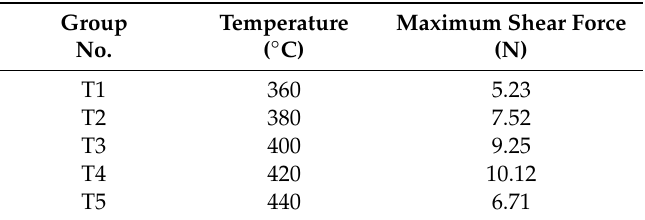
Table 1. Chip soldering test program at di ff erent